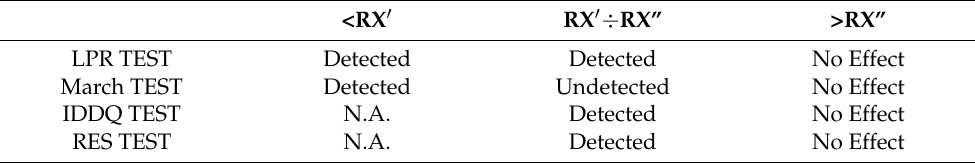
Table 2. Effectiveness of the different test methods with respect to the R1 defect. Figure 8. Effect of the R1 defect on SNM.